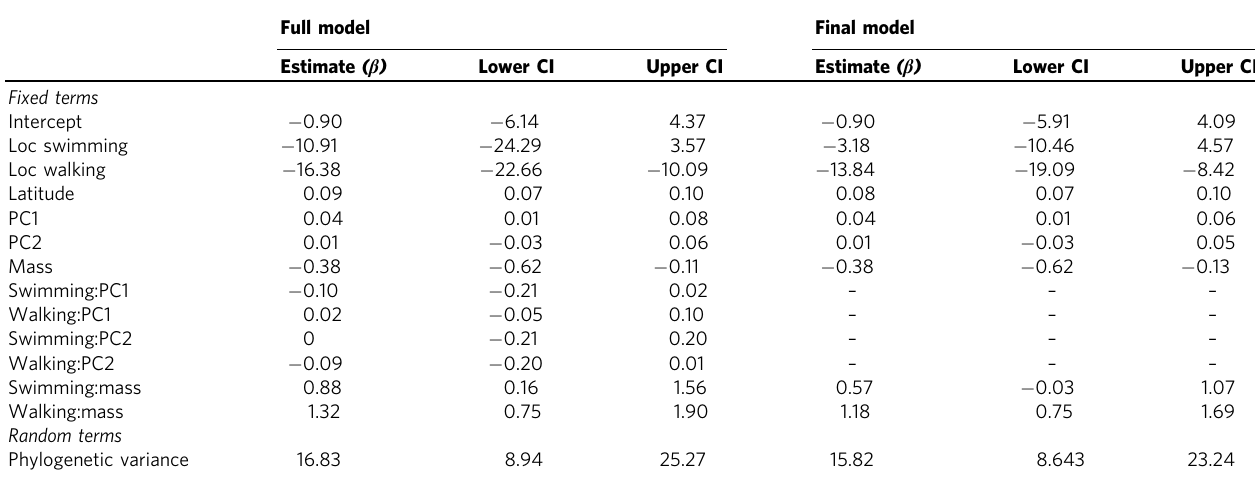
Table 1 Posterior distributions of the parameter estimates of the Bayesian phylogenetic probit mixed-effects models for all